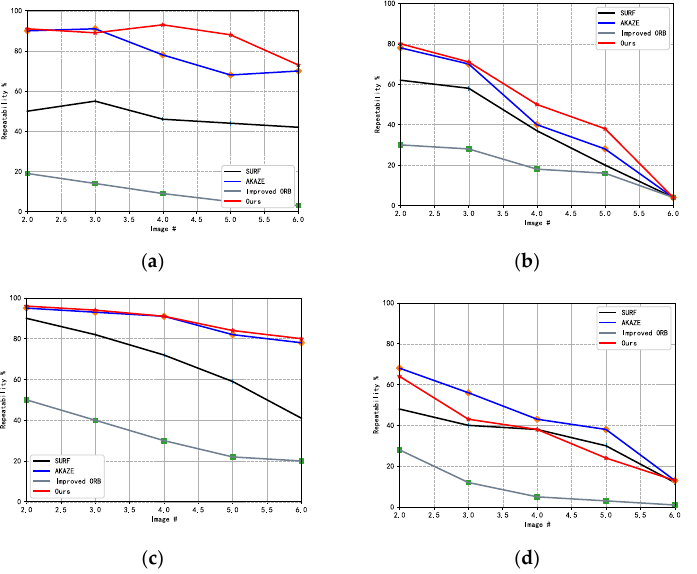
16 of 19 Table 4. Comparison of time consumption and average matching rate. Methods